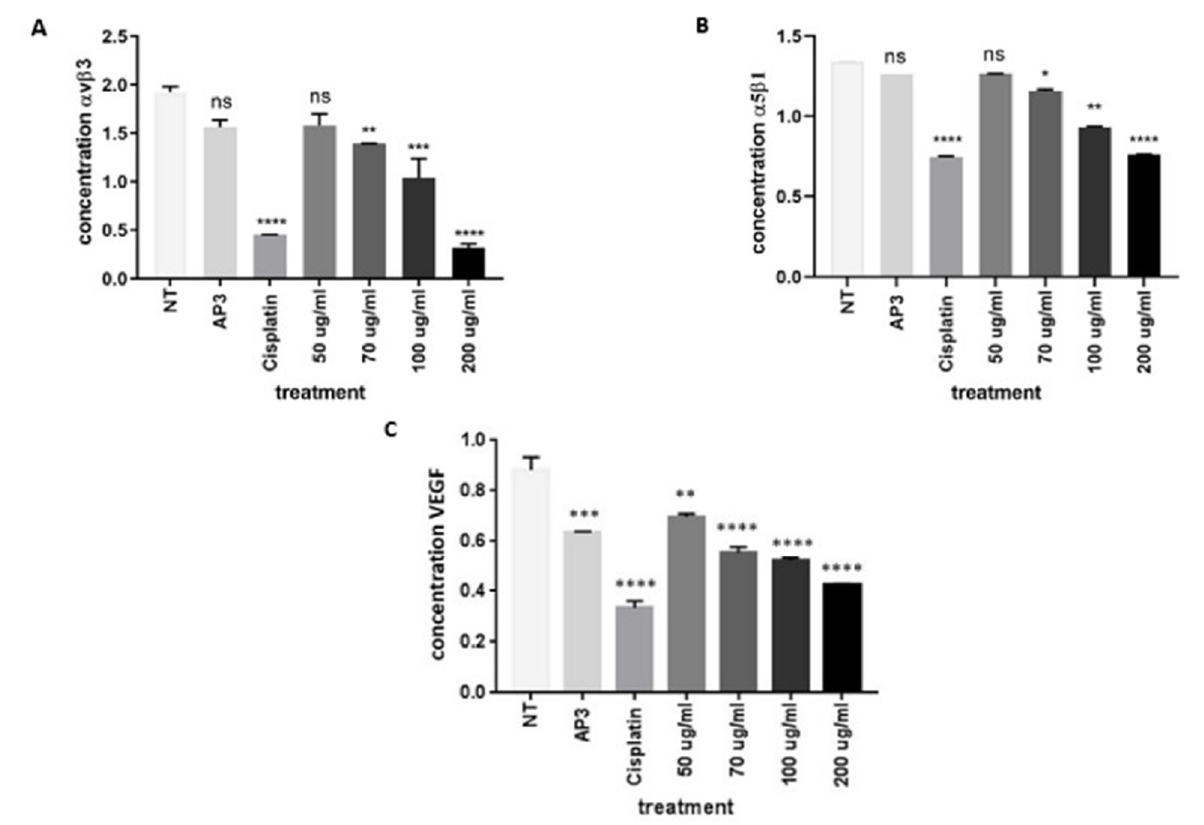
Figure 3. ( A ) The ethanolic extract of Ocimum sanctum Linn. decreased expression of non-small cell lung cancer (A549) integrin α v β 3, as shown by sandwich ELISA. The cells were cultivated in the presence of an inhibitor (AP3) as the positive control, cisplatin as the commercial drug comparison, and EEOS at concentrations of 50, 70, 100, and 200 g/mL for 24 h. A549 cells were then lysed and analyzed via ELISA for the concentration of α v β 3 integrin (ug/mL). Statistical analysis was performed via one-way ANOVA, followed by post hoc Tukey test (NT: non-treated; **, ***, and **** indicate statistically significant values for the non-treated group as a negative control compared with treatment, with p -values of 0.0085, 0.0004, and <0.0001, respectively; ns = not significant). ( B ) Ethanolic extract of Ocimum sanctum Linn. decreased expression of integrin α 5 β 1 in non-small cell lung cancer (A549), as shown by competitive ELISA. The cells were cultivated in the presence of an inhibitor (AP3) as the positive control, cisplatin as the commercial drug comparison, and EEOS at concentrations of 50, 70, 100, and 200 g/mL for 24 h. A549 cells were then lysed and analyzed via ELISA for the concentration of α 5 β 1 integrin (ug/mL). Statistical analysis was performed via one-way ANOVA, followed by post hoc Tukey test (NT: non-treated; *, **, and **** indicate statistically significant values for the non-treated group as a negative control compared with treatment, with p -values of 0.0348, 0.0027, and <0.0001, respectively; ns = not significant). ( C ) Ethanolic extract of Ocimum sanctum Linn. decreased expression of the non-small cell lung cancer (A549) integrin VEGF, as shown by sandwich ELISA. The cells were cultivated in the presence of an inhibitor (AP3) as the positive control, cisplatin as the commercial drug comparison, and EEOS at concentrations of 50, 70, 100, and 200 g/mL for 24 h. A549 cells were then lysed and analyzed via ELISA for the concentration of VEGF ((ug/mL). Statistical analysis was performed via one-way ANOVA, followed by post hoc Tukey test (NT: non-treated; **, *** and **** indicate statistical significance of the non-treated group as a negative control compared with treatment, with p -values of 0.0012, 0.0002, and <0.0001, respectively; ns = not significant).